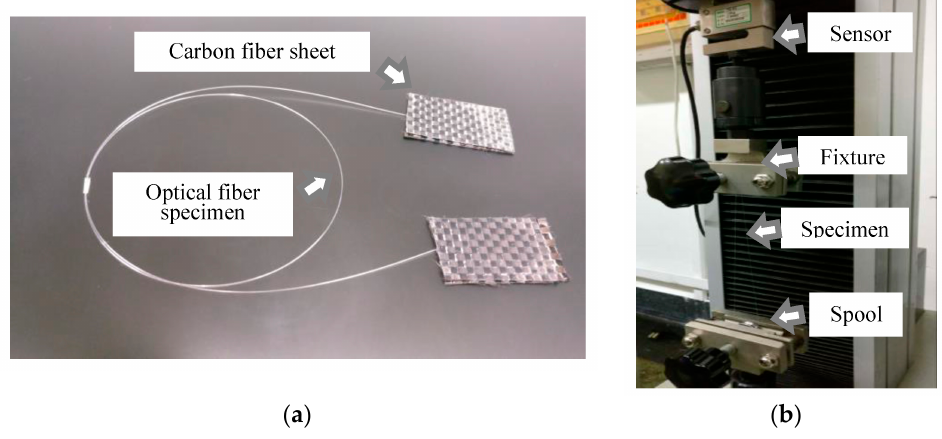
Figure 14. The test specimen and experimental devices: ( a ) optical fiber specimen and carbon fiber sheets; ( b ) experimental devices and the way to apply loads.